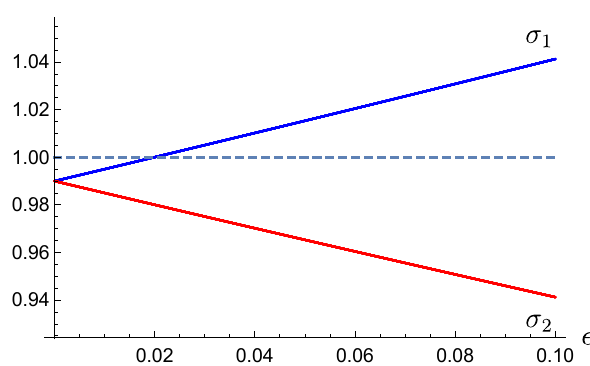
Figure 1 . The behaviour of (cid:27) 1 and (cid:27) 2 as a function of the (cid:15) parameter which changes from 0 to 1. The continuity in changes of singular values with (cid:15) is evident. We are looking for the precision of the parameter (cid:15) for which (cid:27) 1 has within precision of calculations a common value with horizontal dashed line at 1, which represents the physical limit, see table 2. Initial singular value ( (cid:27) ) 0.99 1